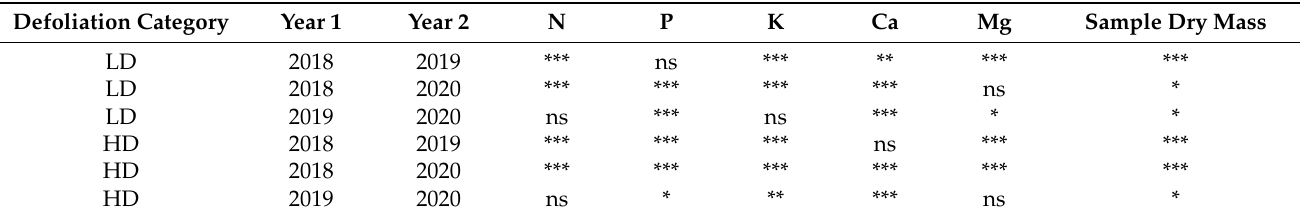
Table 1. Results of Holm pairwise comparisons of foliar nutrient concentrations and sample dry mass within a defoliation category and between sampling years (NS–not significant, * p < 0.05, ** p < 0.01, *** p <